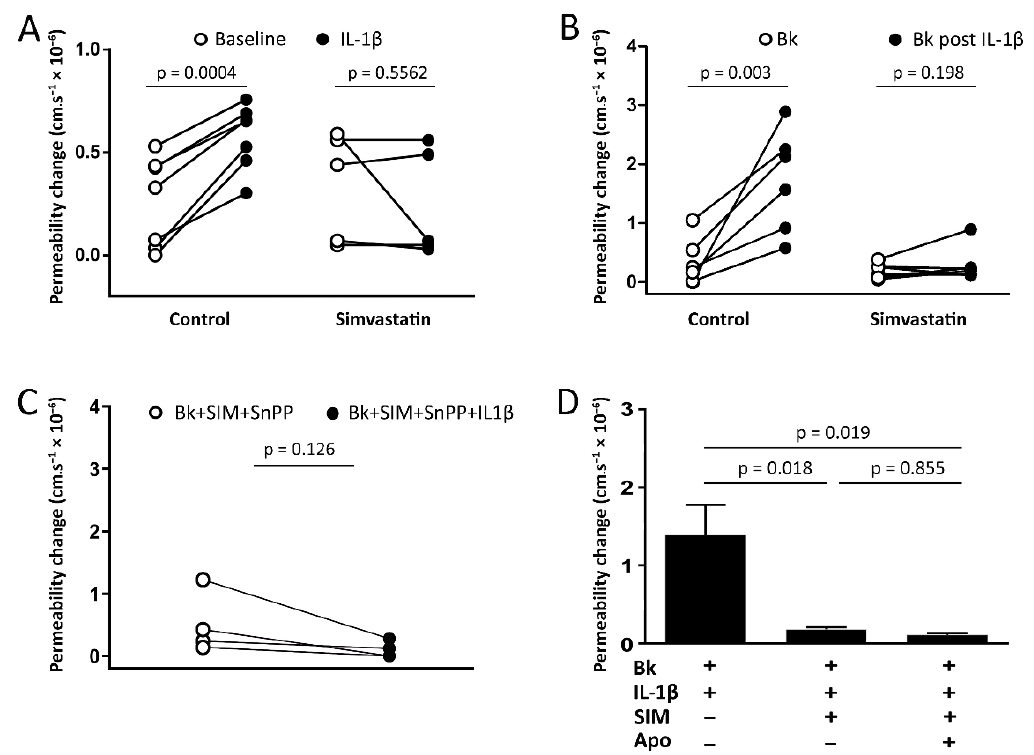
Figure 6. Pretreatment with simvastatin abolishes potentiation of bradykinin-induced microvascular permeability by IL-1 β . ( A ) IL-1 β (30 pM) application itself for 10 min resulted in a small permeability increase in non-treated rats (control), which was abrogated by the pretreatment with simvastatin (5 mg · mL − 1 ) 24 h before. ( B ) Potentiation of bradykinin-induced (100 nM) permeability by IL-1 β (30 pM) was compared in cremaster muscle post-capillary venules from control and simvastatin pretreated (5 mg / kg; i.p.) animals. ( C ) Inhibition of HO-1 with SnPP (5 µ M) did not restore IL-1 β potentiation of bradykinin-induced permeability in simvastatin pretreated (5 mg / kg; i.p.) animals. Data were analyzed using a paired Student’s t -test. ( D ) Apocynin had no e ff ect on simvastatin-treated animals, suggesting that the pretreatment with simvastatin was su ffi cient to prevent the assembly of NADPH oxidase induced by IL-1 β . One-way ANOVA with Tukey’s multiple comparison test. Data denote mean ±